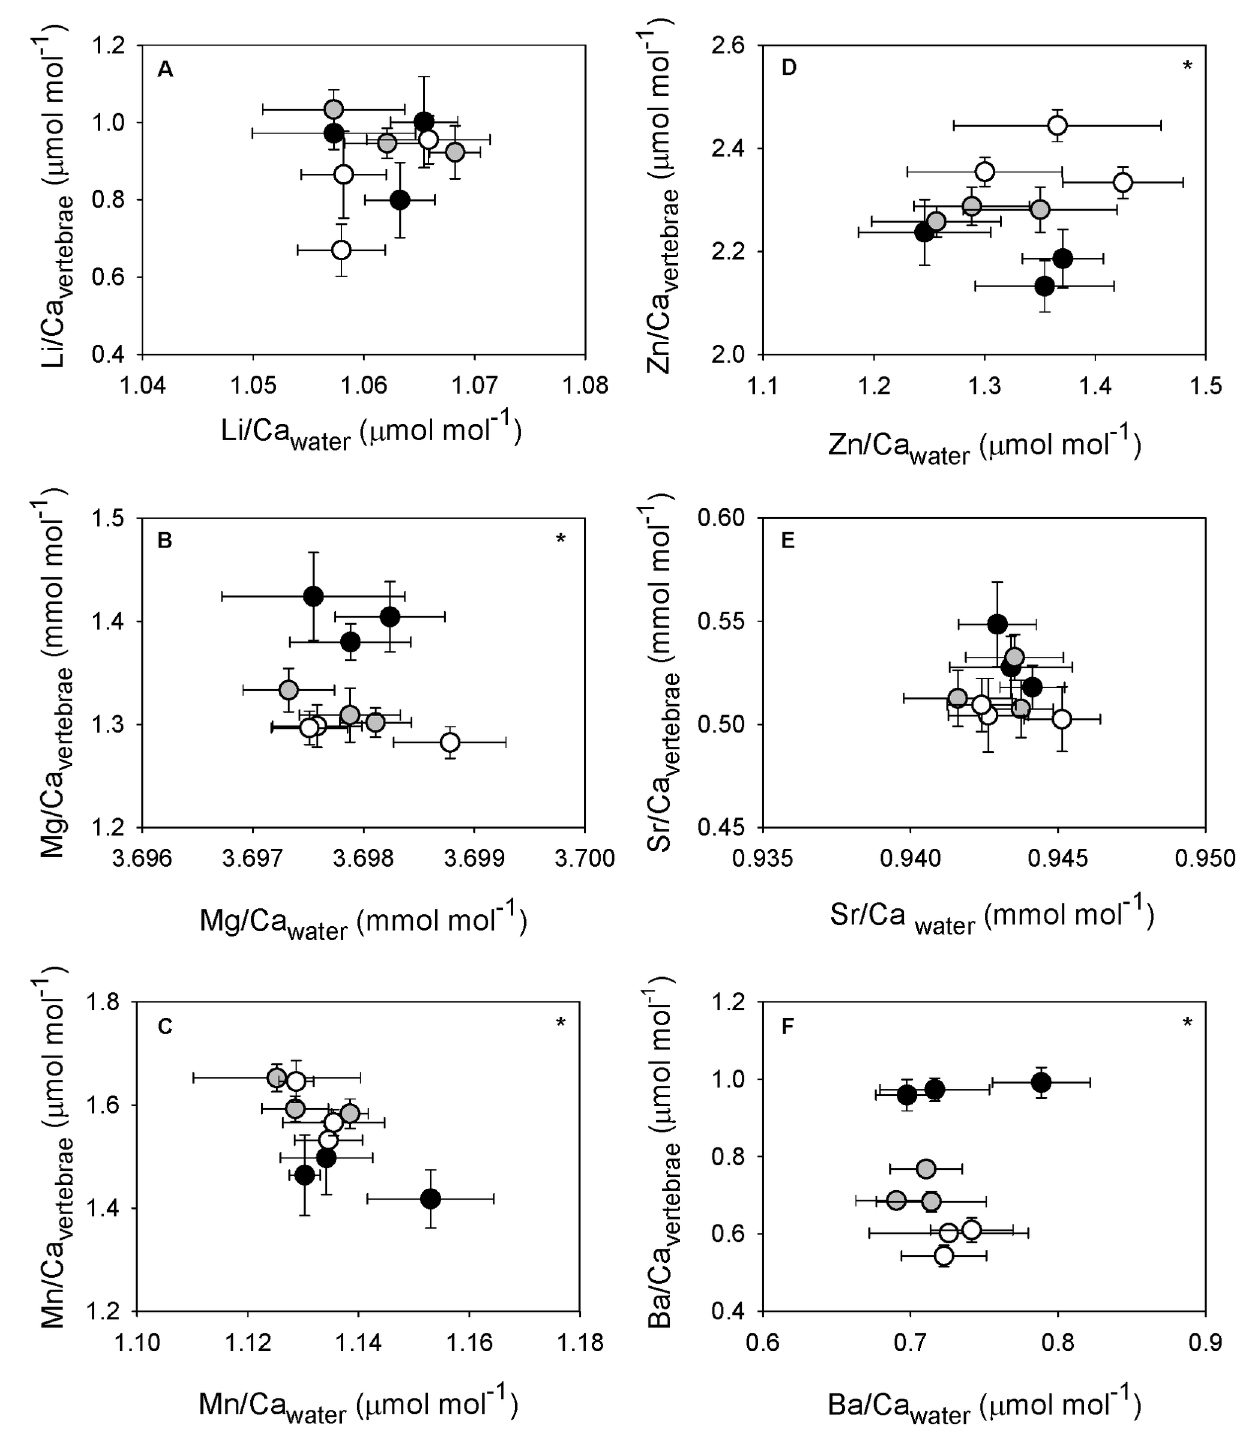
Figure 2. Relationships between water and vertebral elemental ratios by temperature treatment. Mean ± standard error of element to calcium ratios for water and vertebral samples. Black circles represent 15°C treatments, grey circles 18°C treatments, and open circles 24°C treatments. (A) lithium, (B) magnesium, (C) manganese, (D) zinc, (E) strontium, and (F) barium. Element to calcium ratios were log -transformed. Significant temperature effects are indicated by (*). 10